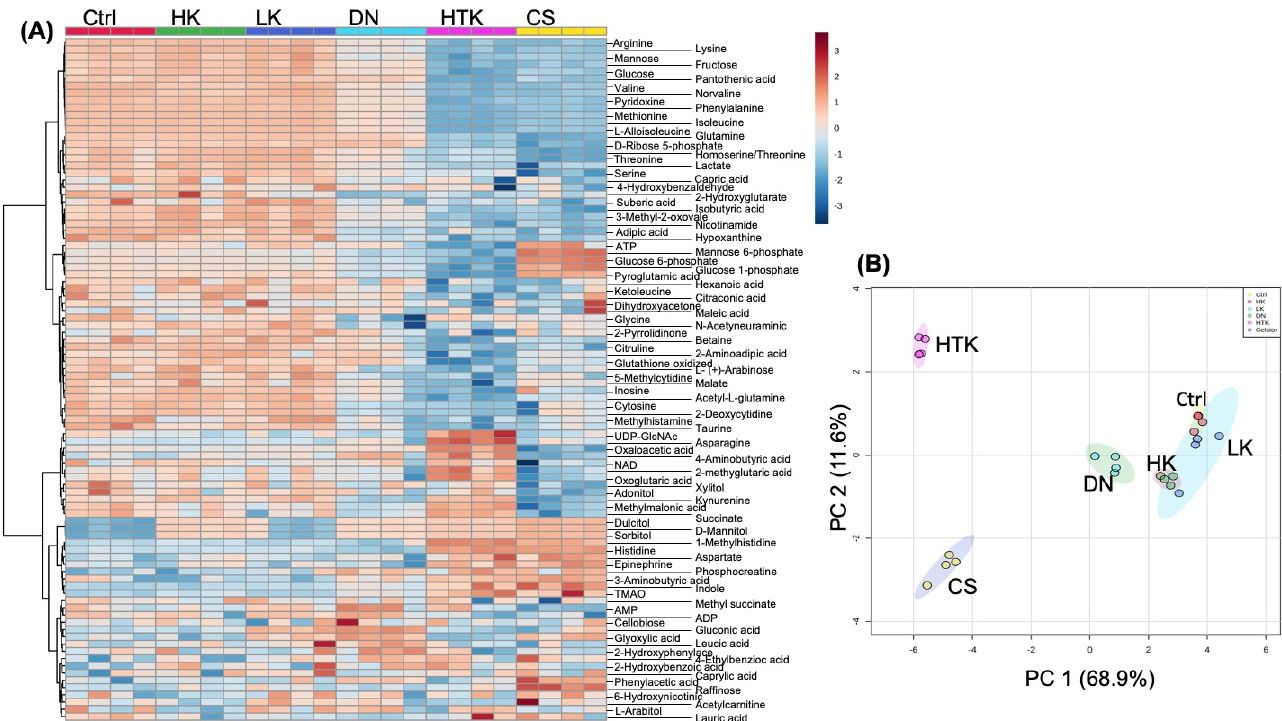
Figure 1. Effects of 5 Cardioplegic Solutions on Cellular Metabolism. AC16 human cardiac myocytes were seeded in 6-well plates and cultured in DMEM containing 12.5% FBS. When reaching 90% confluency, cells were placed in 0.5% FBS/DMEM/F12 for overnight serum starvation. The cells were treated with HK, LK, DN, HTK, and CS for 4 h before extraction of aqueous metabolites from cell lysates for LC-MS/MS-based metabolomics. The overall metabolic profile differences between control (Ctrl) and cells treated with a cardioplegia solution (n = 4) are shown in the heatmap ( A ) and by a principal component analysis (PCA) score plot ( B ).